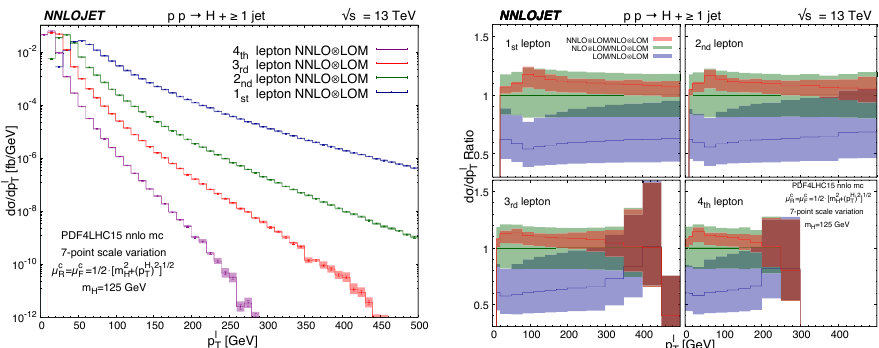
Figure 11. Transverse momentum distributions for each of the four leptons from Higgs boson decay associated with a jet for ATLAS II cuts.